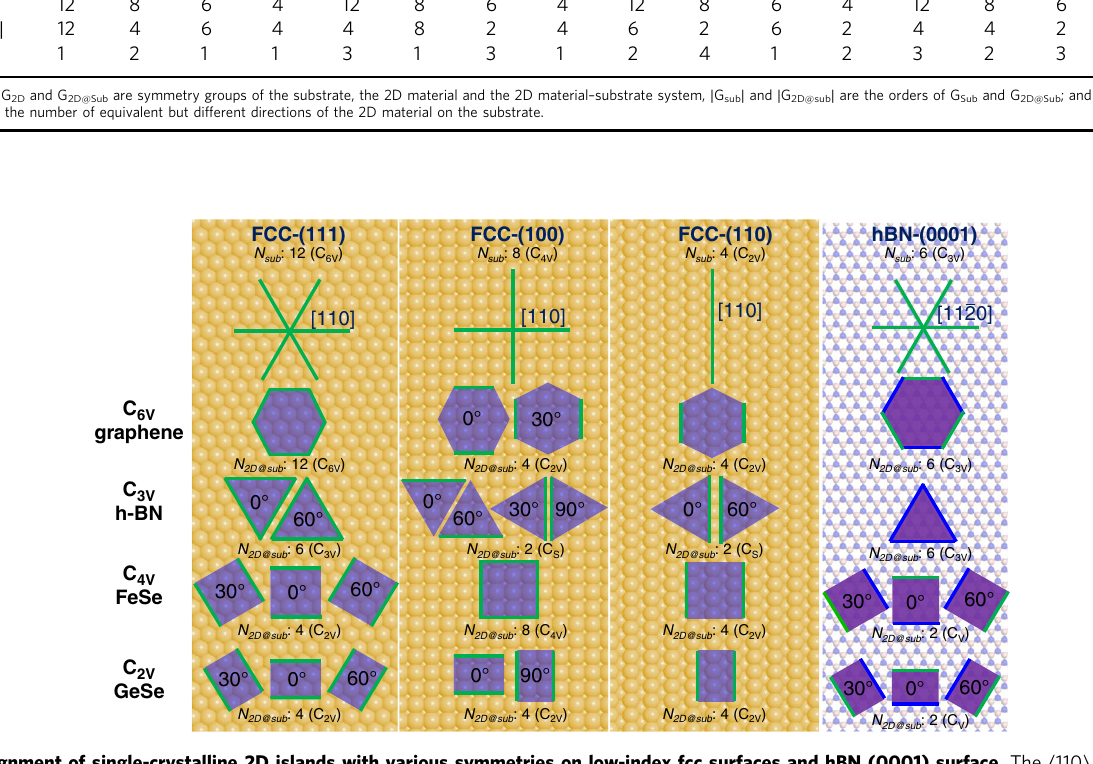
Fig. 4 Alignment of single-crystalline 2D islands with various symmetries on low-index fcc surfaces and hBN (0001) surface. The 〈 110 〉 or 〈 11 (cid:1) 20 〉 crystallographic orientations of substrates are denoted by green lines. 2D islands are represented by purple polygons. The symmetry groups of the 2D material, substrate, and the system of the 2D island on the substrate are provided. The number of different symmetry operations of the substrate and the whole system are N sub and N 2D@sub , respectively. The nitrogen and boron atoms are represented by blue and pink spheres, respectively. The relative anti- clockwise misorientation angles of grains with different orientations are given. Due to the C 3V symmetry of hBN, the edges of a 2D material, which are parallel to hBN 〈 11 (cid:1) 20 〉 directions, have different local environments and not equivalent, and thus are denoted by blue and green lines,